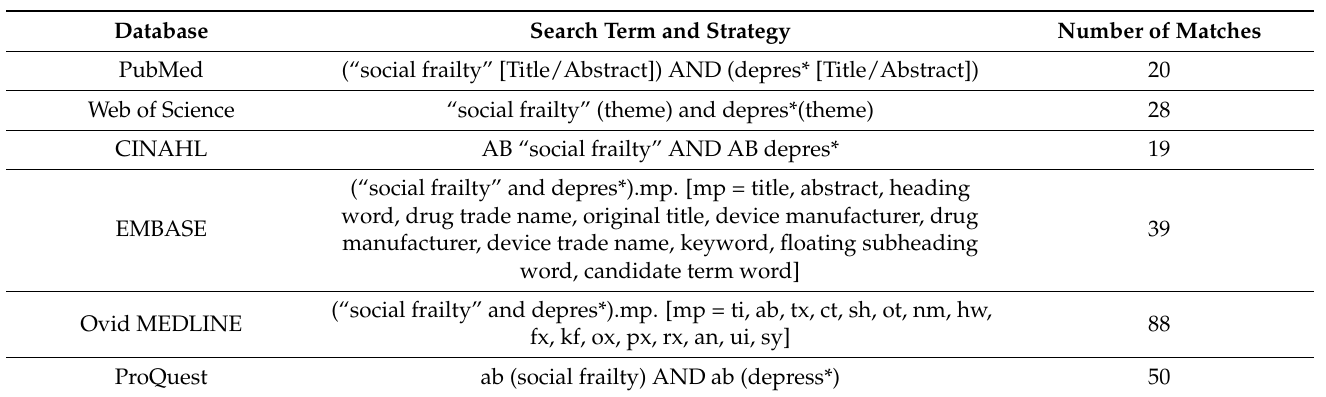
Table 1. Database